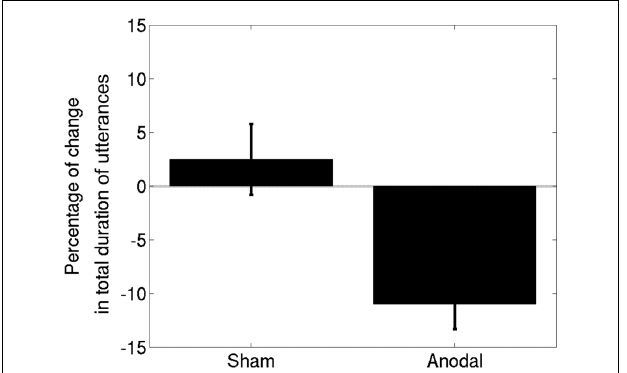
FIGURE 2 |The results for six participants with Broca’s aphasia, represented as means ± SEM. Note that a decrease in the total duration signifies an improvement in verbal fluency. Anodal- tDCS led to a significantly greater improvement compared to sham